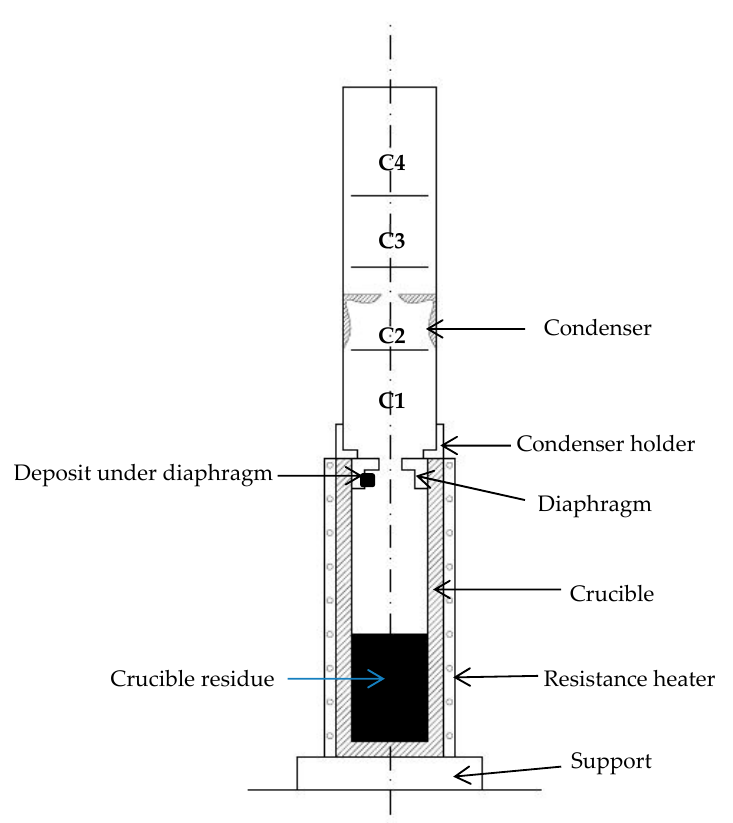
Figure 4. Illustration of Revel’s distillation column (C1–C4: compartments of condenser).